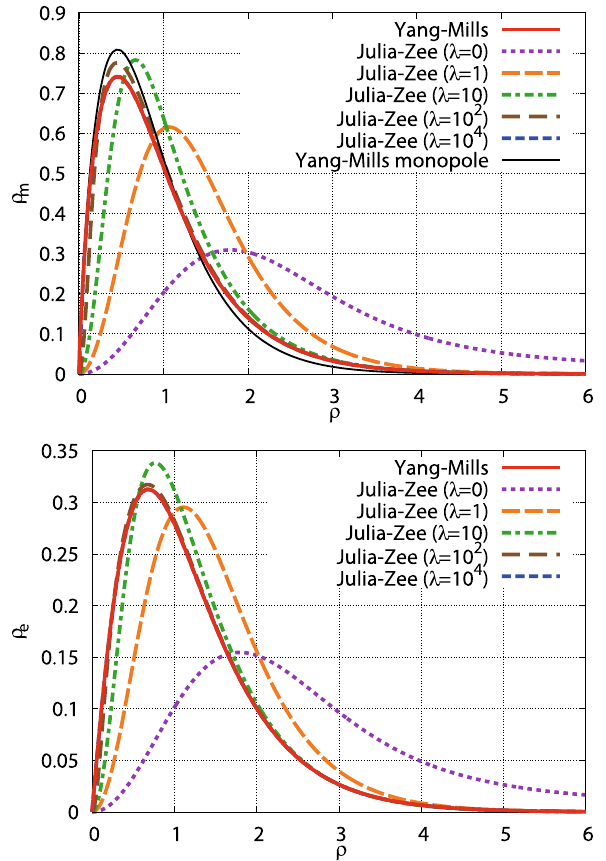
Fig. 3 (Toppanel)Themagneticchargedensity ρ m and(Bottompanel) electric charge density ρ e as functions of ρ = g v r at the C = 0 . 5